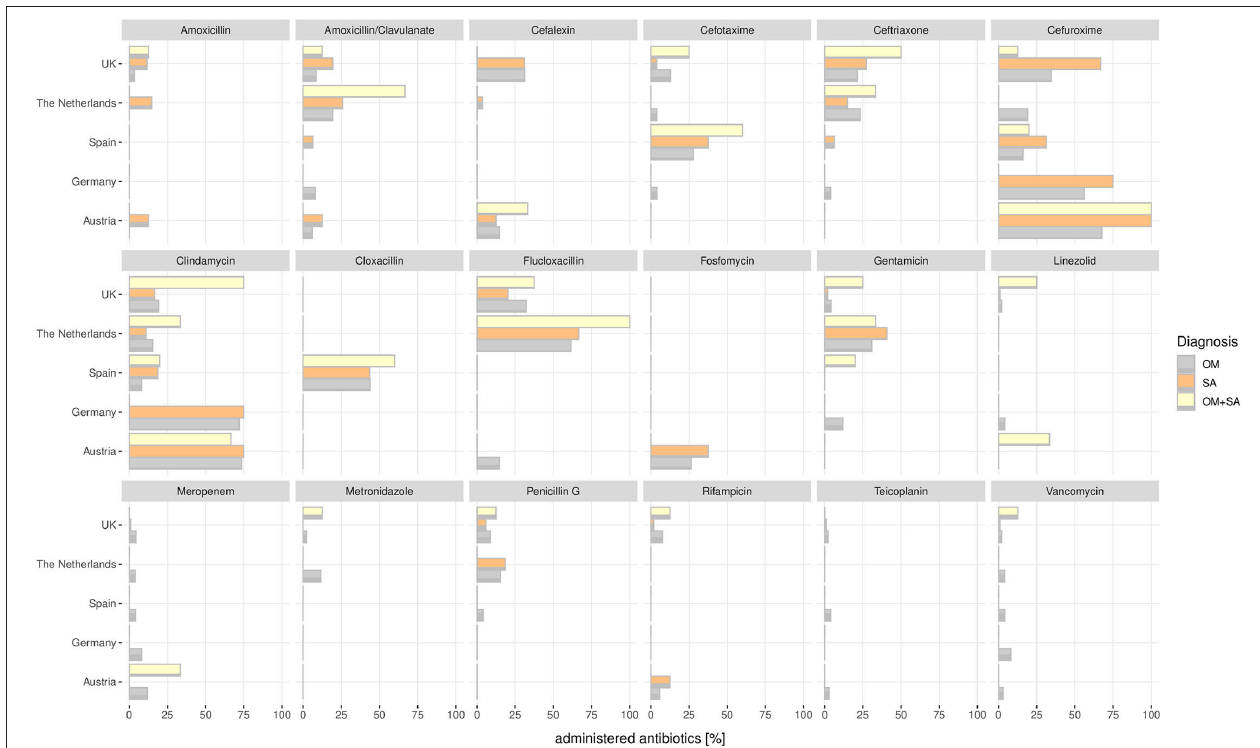
FIGURE 6 | Percent of administered antibiotics calculated for each country in the consortium and each OAI are